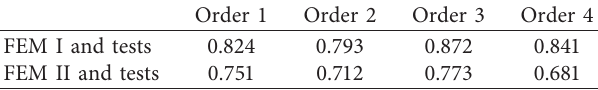
Table 7: Mode shape similarity between FEM and field